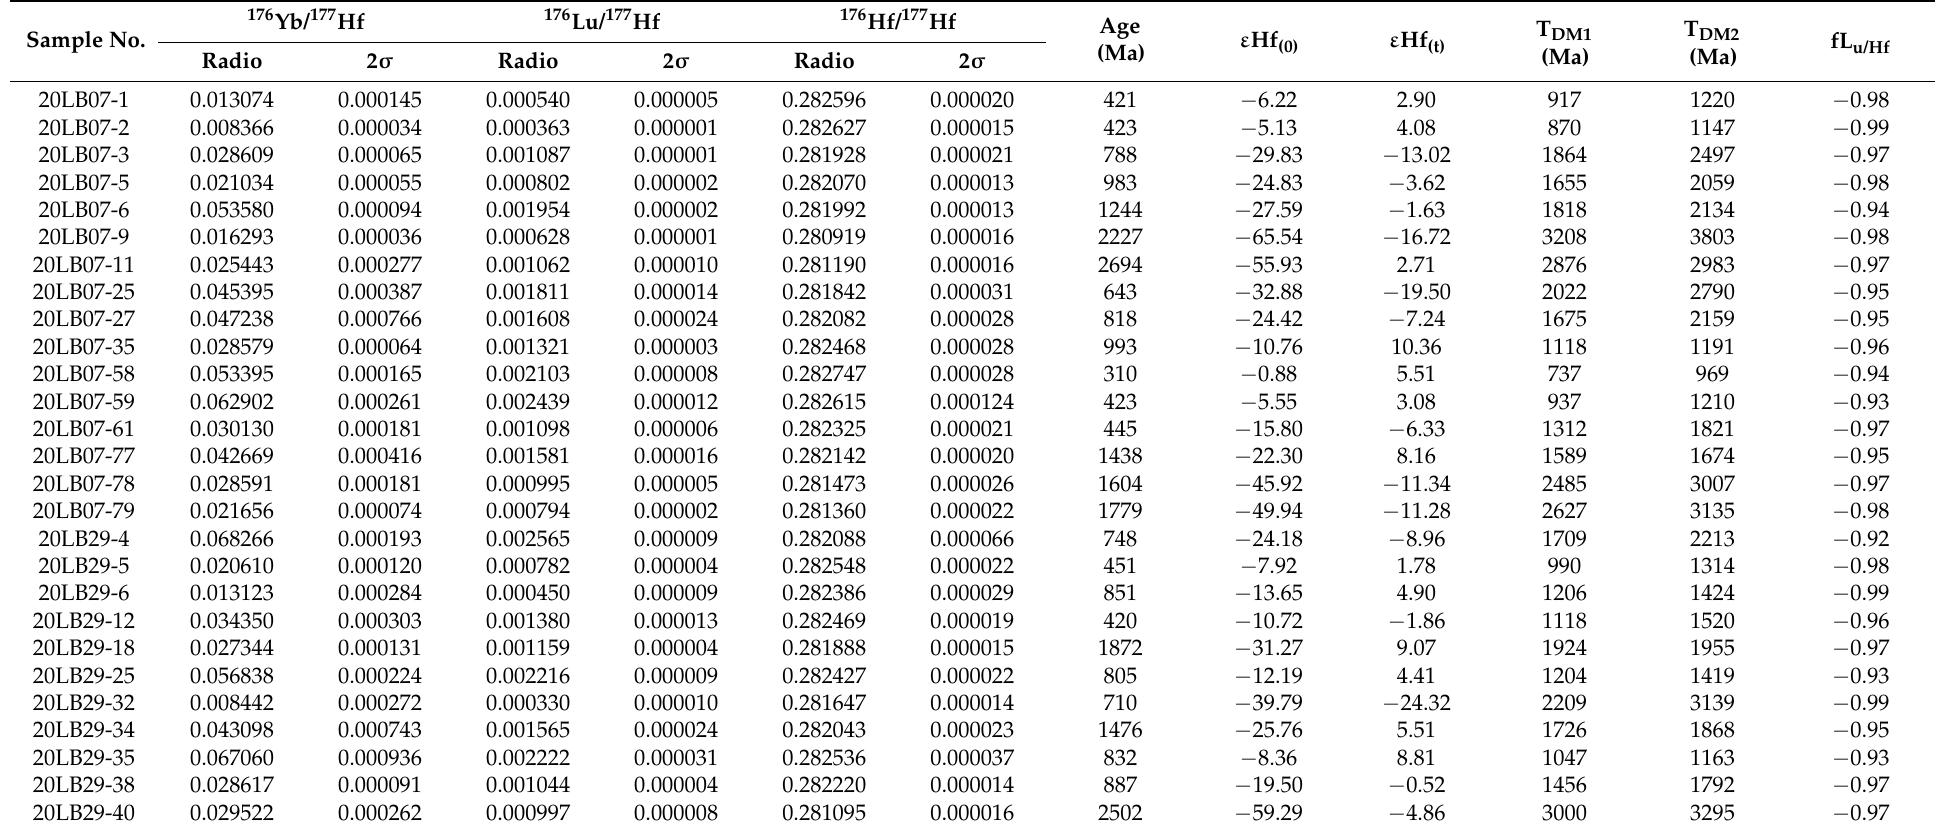
Table 2. Zircon Lu–Hf data of the Liba